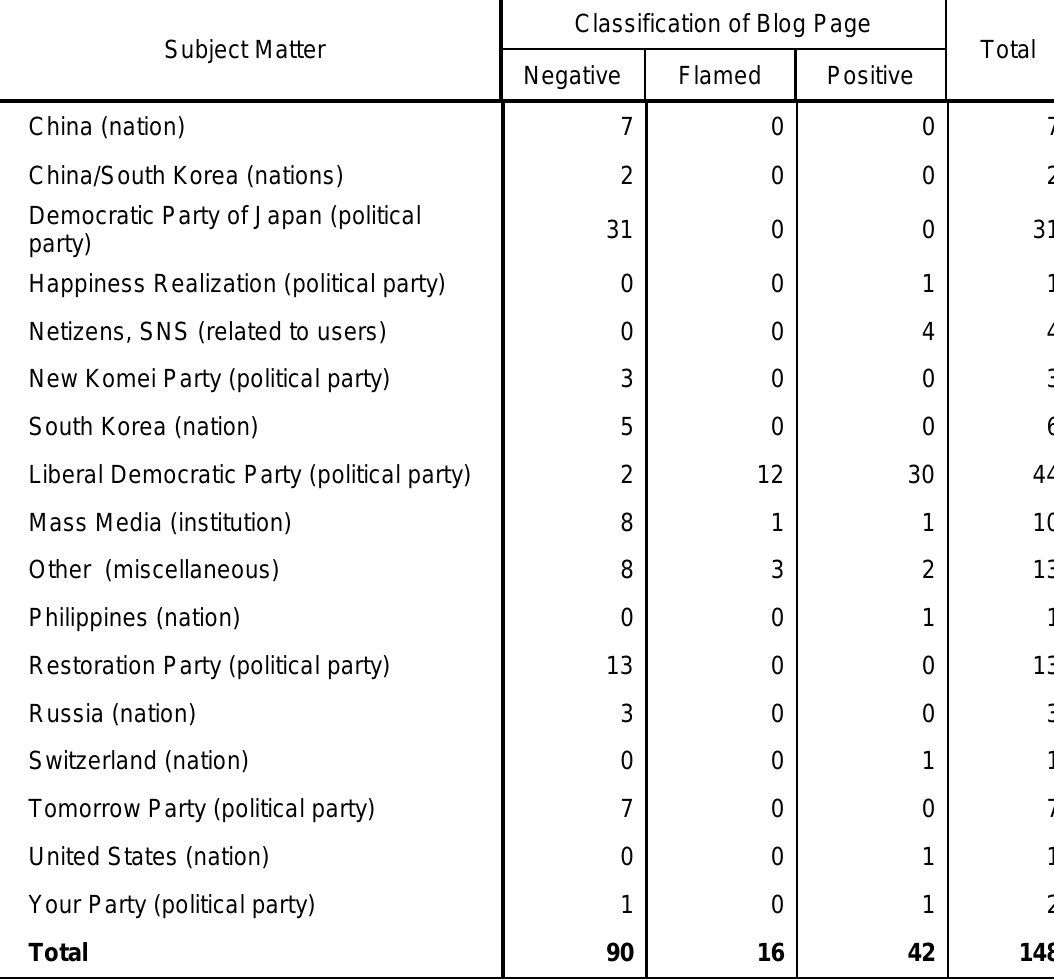
Table 1. Subject and Discussion context of Thread Blogs Nov. 16 – Dec. 20,